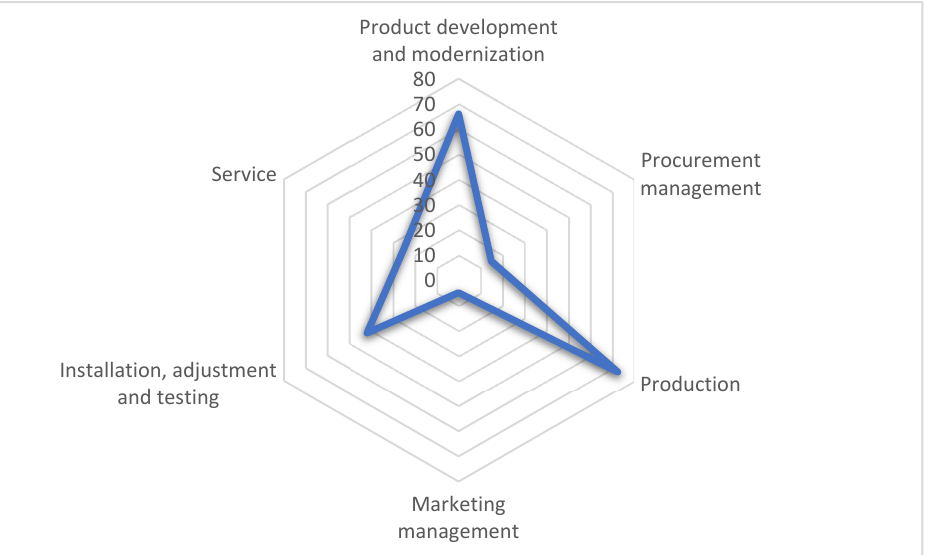
Figure 6. The level of use of digital assets of the enterprise in the implementation of major business processes.